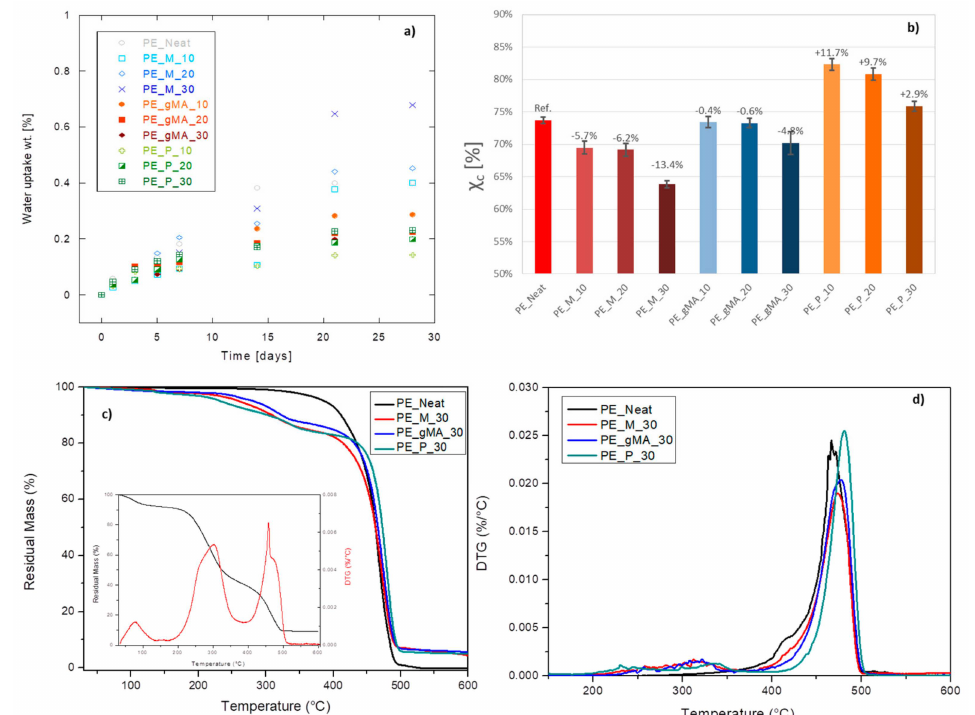
Figure 4. Water uptake as a function of treatment and weight amount ( a ) and crystallinity evaluation by DSC ( b ) of BioPE_CSS composites films, TG ( c ) (TG / DTG curves of unmodified CSS in the insert) and DTG ( d ) curves of neat BioPE and BioPE_CSS composites (bulk) at 30 wt % of untreated (PE_M_30), alkali treated (P_gMA_30) and palmitoyl chloride treated CSS